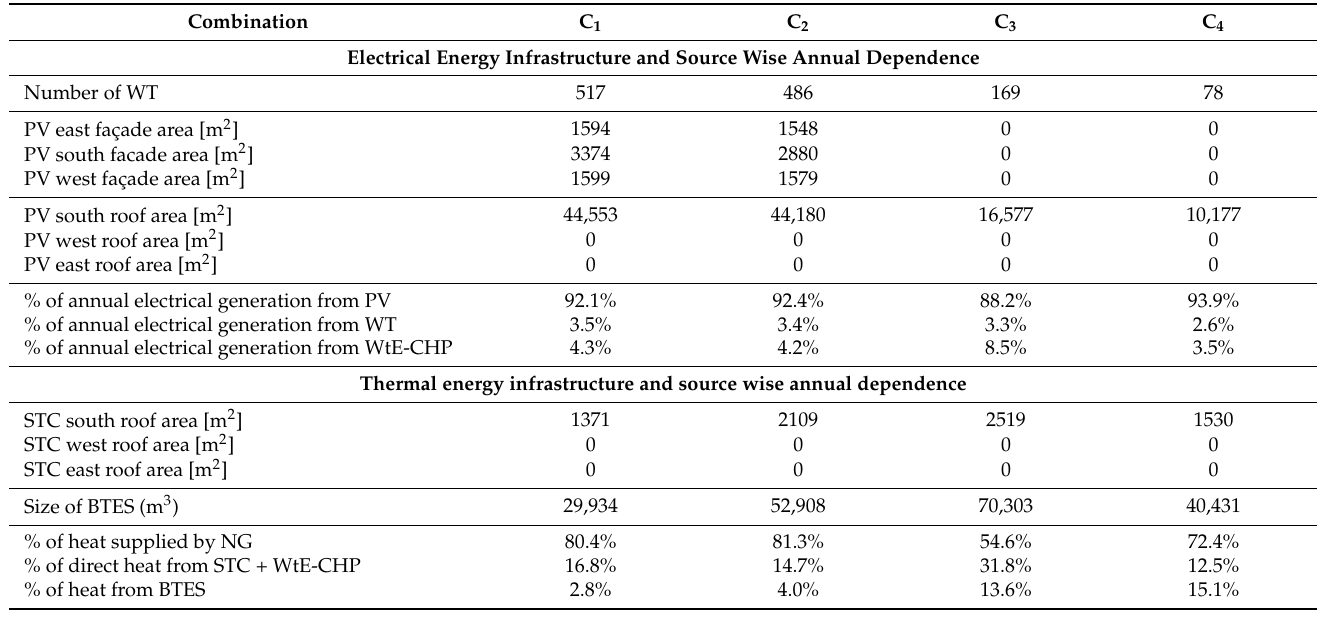
Table 4. Mixture of clean energy sources for attaining electrical neutral